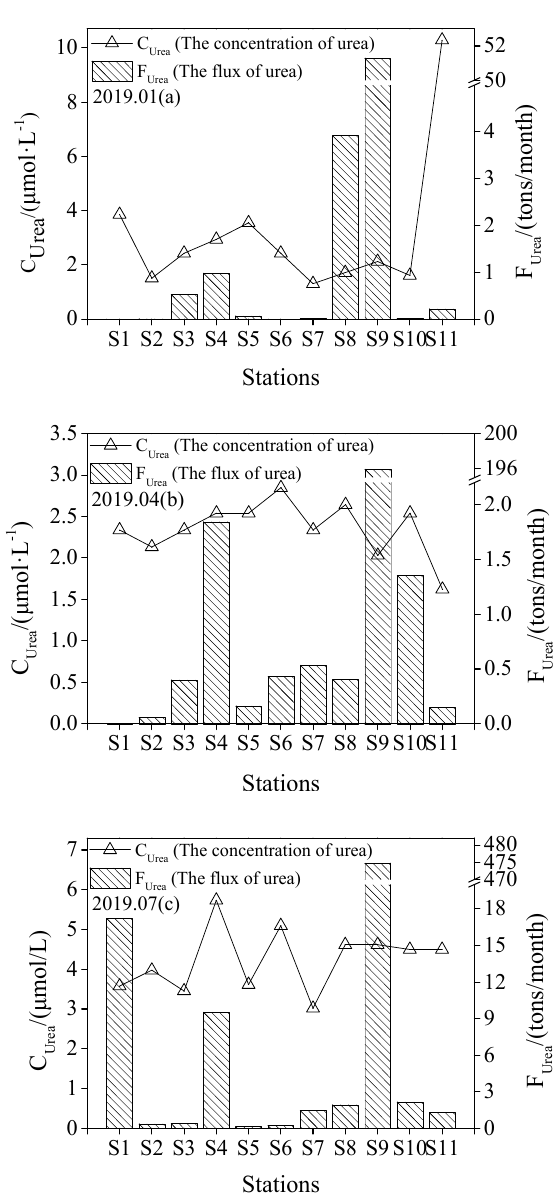
Figure 4. The concentration (C Urea ) and flux (F Urea ) input variation of urea in January (a), April (b) and July (c) in the ZJB.